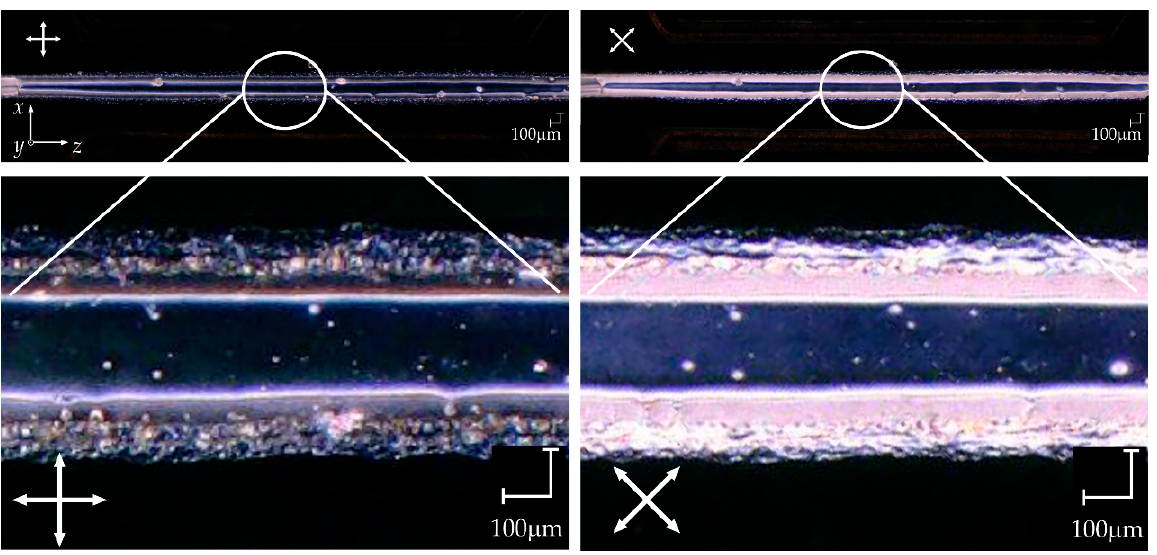
Figure 5. Microchannel in the PDMS:glass structure fabricated using the UV-cured photostencil film. The channel was infiltrated with E7 NLC and then observed between crossed polarizers. The photographs in the upper row show the entire length of the microchannel. The LC molecules in the central part of the channel are orthogonal to the azimuthal plane, leading to minimum light transmittance when the sample is placed between crossed polarizers (left-hand side). No change of transmitted intensity is observed when rotating the sample except in the vicinity of the channel walls (right-hand side).